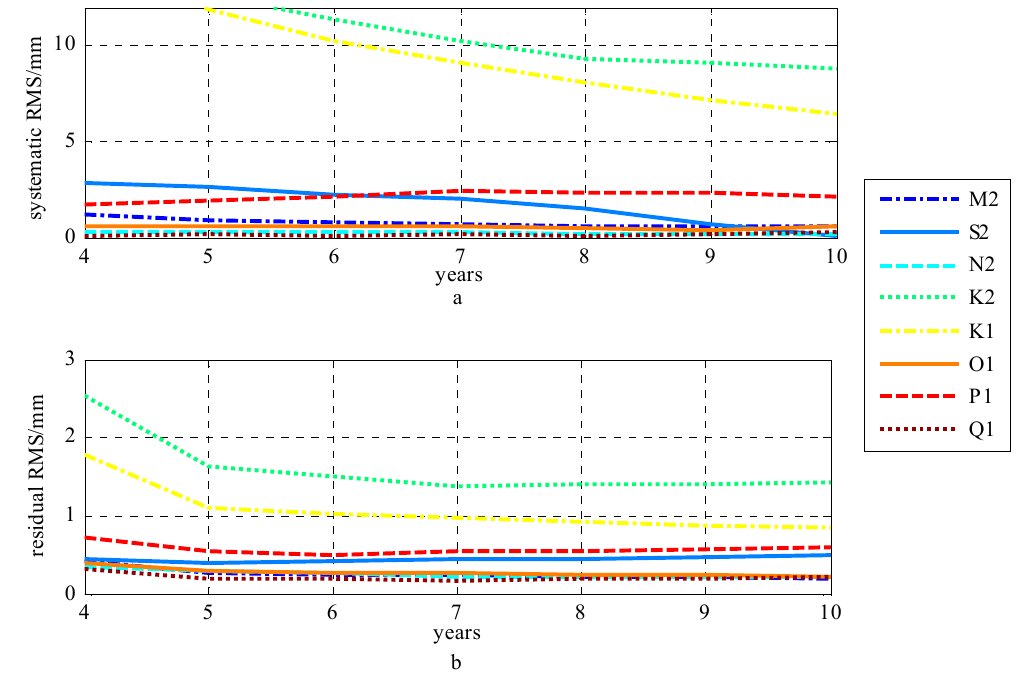
Figure 3. GPS-estimated tidal stability for the eight tidal constituents: ( a ) the RMS of the systematic phasor difference; ( b ) the RMS of the residual phasor difference corresponding to ( a ).